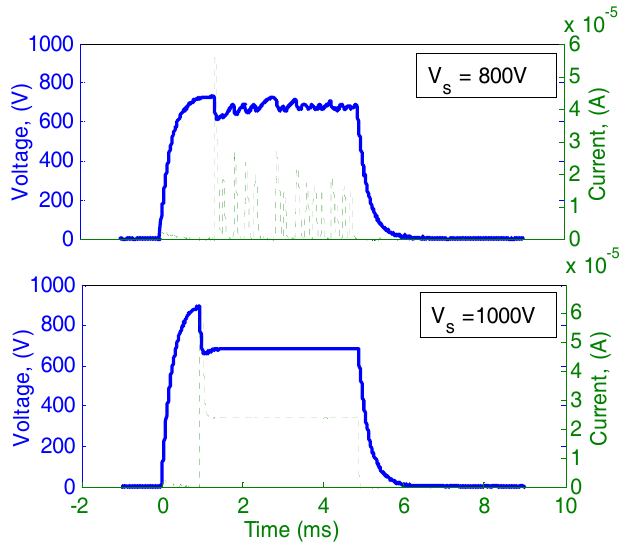
Figure 4. Current and voltage waveforms for intentionally shortened (5 ms) discharge duration with fresh Si wafer at 150 μ m gap distance and 6.6 sccm gas flow rate, as self-pulsing at 800 V and stable DC at 1000 V.